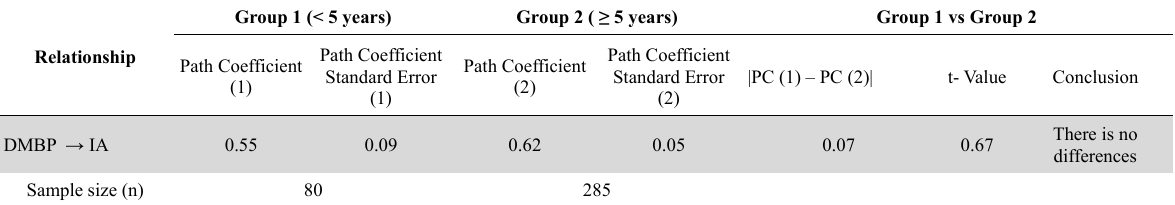
Evaluation on tenure as moderator variable